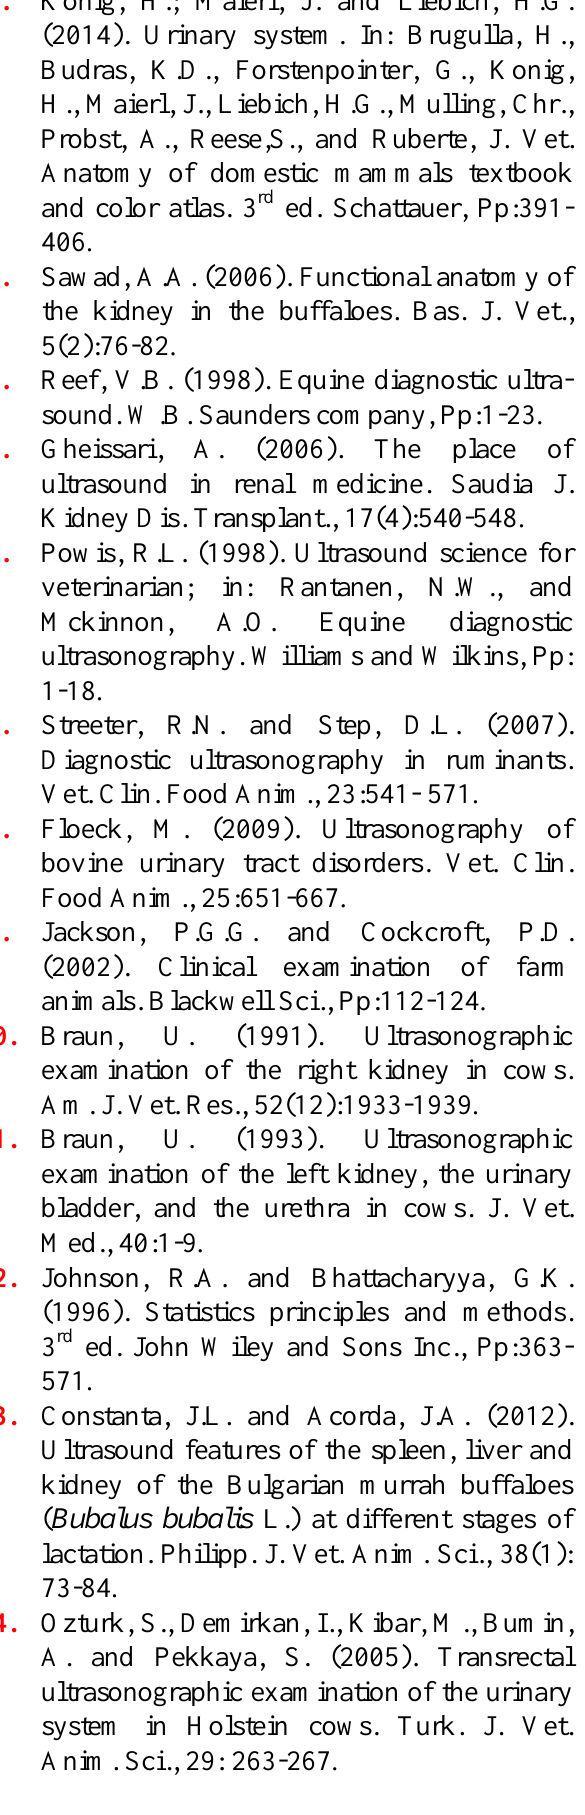
Table, 4: Correlation of right kidney thickness (cm) (Mean±SD) with animal age months).